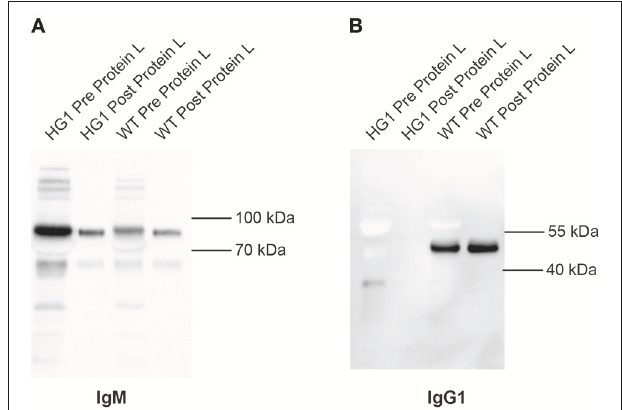
FIGURE 3 | IgG1 does not associate with light chains in HG1 mice. (A) Western blotting indicating the levels of IgM derived from the sera of HG1 and WT mice before and after the protein L treatment. (B) Western blot showing the levels of IgG1 derived from the sera of HG1 and WT mice before and after the protein L